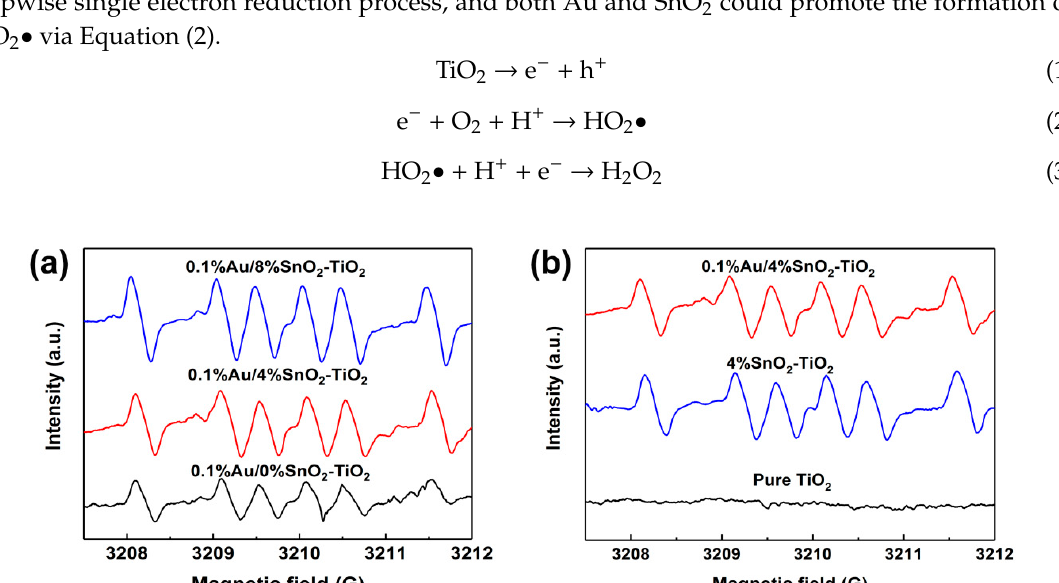
Figure 3. ( a ) In situ ESR spectra of the 0.1% Au/SnO 2 -TiO 2 samples with different Sn/Ti ratios under UV light irradiation. ( b ) In situ ESR spectra of the samples (4% SnO 2 modified anatase TiO 2 ) with and without Au cocatalyst under UV light irradiation.